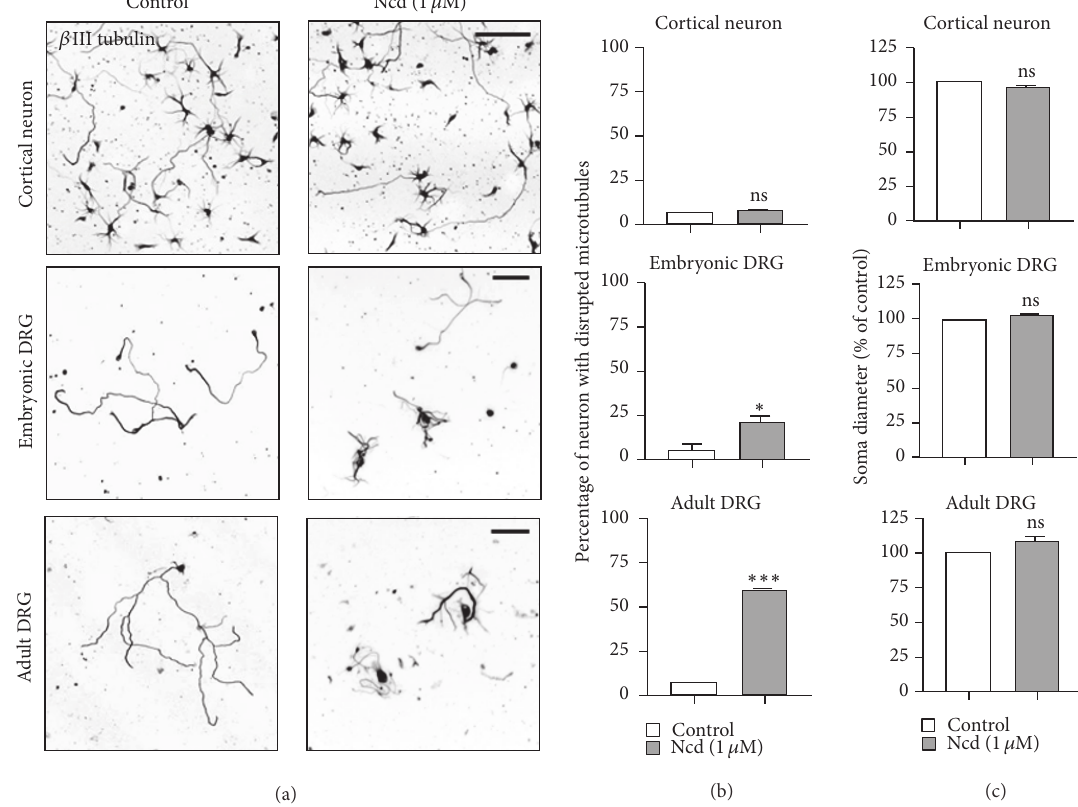
Figure 7: Nocodazole-induced degeneration in different types of neurons. (a–c) Embryonic (E15.5) cortical neurons, embryonic (E13.5) DRG neurons, or adult DRG neurons were cultured in the absence or presence of nocodazole (Ncd) (1 𝜇 M, 30 min), as indicated. Neurons were immunostained with anti-Tuj1 antibodies. Representative images (a) and quantification of axon degeneration (b) and soma diameter (c) are shown. Scale bar, 50 𝜇 m. ∗ 𝑝 < 0.05 and ∗∗∗ 𝑝 < 0.001; ns, statistically not